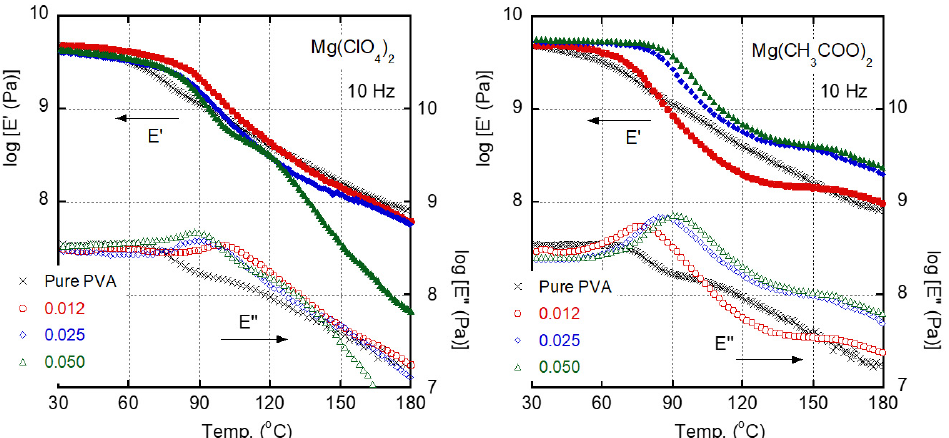
Figure 4. Temperature dependence at 10 Hz of tensile storage modulus E’ and loss modulus E” of films containing various molar ratios of Mg(ClO 4 ) 2 ( left ) or Mg(CH 3 COO) 2 ( right ); (x symbols) pure PVA, (circles) 0.012 molar ratio, (diamonds) 0.025 molar ratio, and (triangles) 0.050 molar ratio.